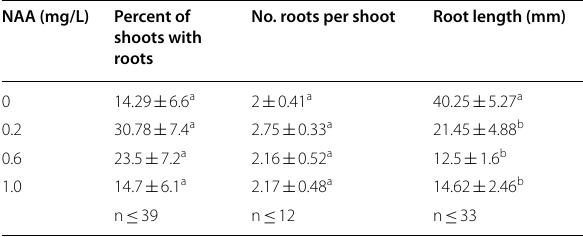
Values are means SE after 4 weeks on media. Means followed by the same ± letter in a column indicate no significant difference by Tukey’s multiple comparison test or pairwise Fisher’s exact test (P <